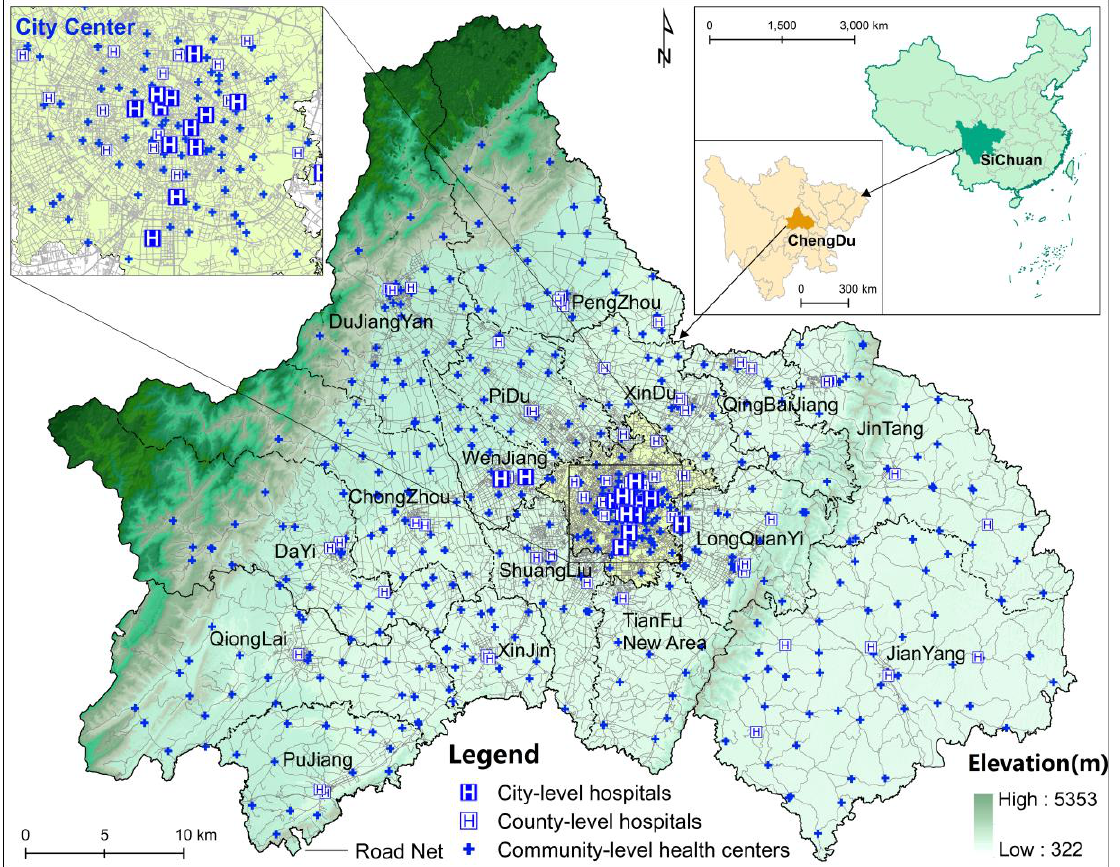
Figure 3. Overview of Chengdu and distribution of healthcare institutions.